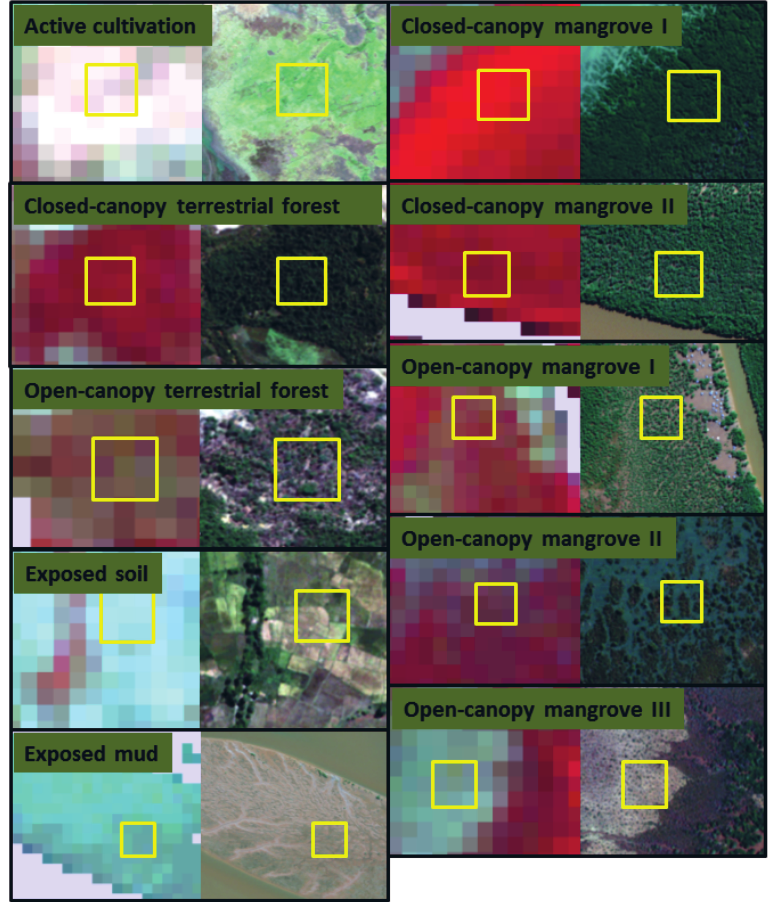
Figure 3. The appearance of mapped classes in moderate spatial resolution Landsat imagery (false color composites of bands 3, 5, and 4, wherein terrestrial and mangrove vegetation appear in shades of red: left-side boxes) and finer spatial resolution WorldView-2-2 and Quickbird imagery (true color composites: right-side boxes). Yellow boxes represent 90 × 90 m reference